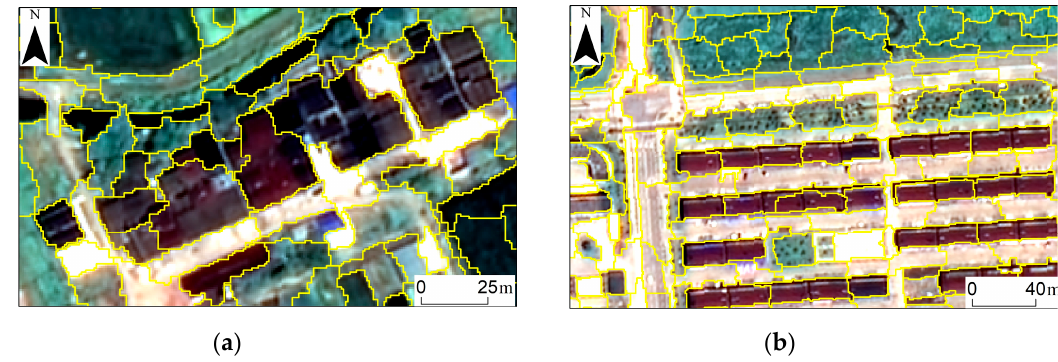
Figure 6. Subset examples of the segmentation results in rural ( a ), and town areas ( b ). The yellow lines represent the segmentation results at the scale of 41. Images are presented in true color.